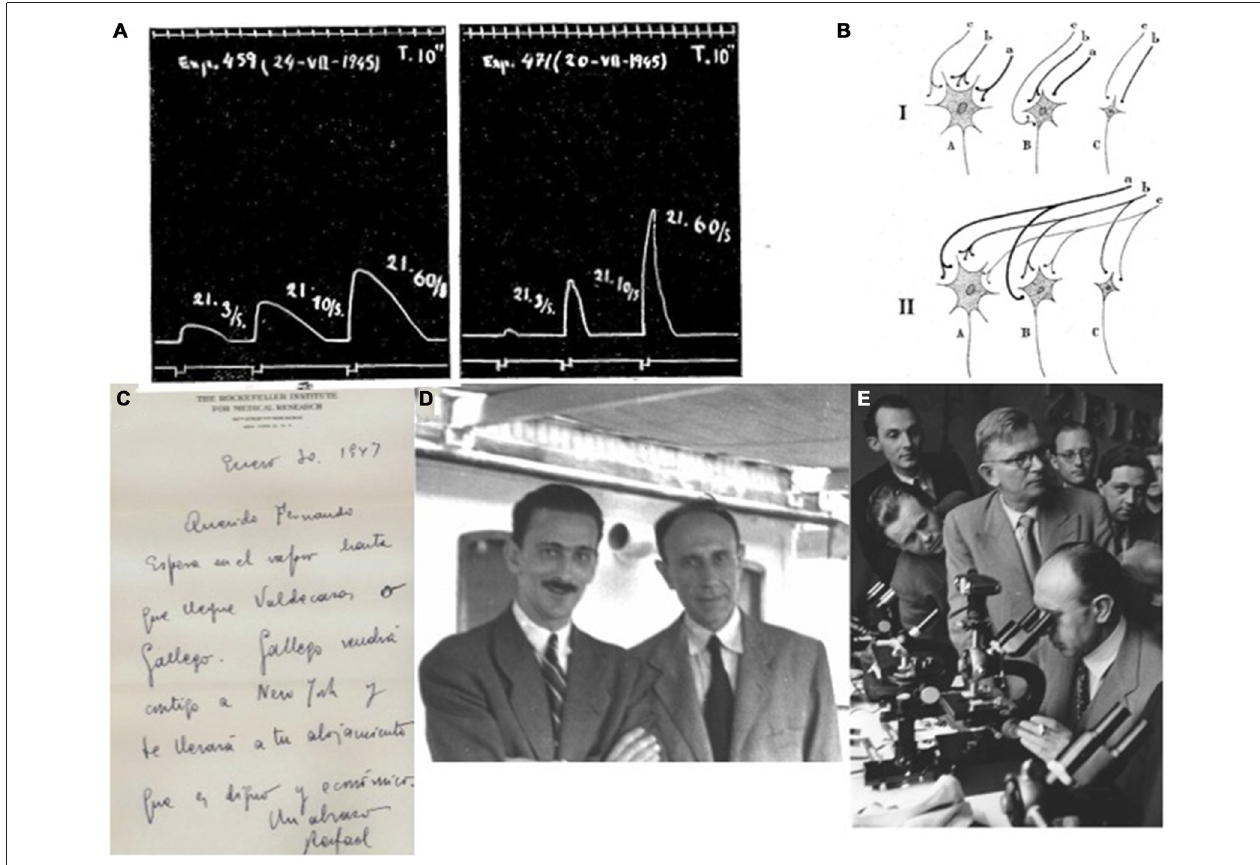
FIGURE 5 | Post-war de Castro on the autonomic nervous system and their synaptic structure. (A) Electromiographic recordings of the nictitant membrane of the adult cat where the sympathetic superior cervical ganglion has been innervated by rami from the VI-c and VII-c nerves (de Castro and Herreros, 1945). This 10 s-recording shows that the intensity of the contraction correlates with the frequency of the tetanic stimulation. (B) Schematic representation of the preganglionic convergence of fibers ( a , b , c ) onto ganglionic cell types ( A , B , C ). The thickness of the fibers is representative of their thickness in vivo . In this it is assumed that ganglion cells can trigger when activated by two boutons simultaneously, or in the slow fibers ( c ) when a sinchronic impulse via a-b facilitates it (de Castro and Herreros, 1945). (C) Original letter from Rafael Lorente de Nó to Fernando de Castro (dated at the Rockefeller Institute, New York on January 30th, 1947): “Dear Fernando, Wait at the shipboat till the arrival of Valdecasas or Gallego. Gallego will come with you to New York and will bring you to your accomodation, that is worthy and economic. Hugs, Rafael” (translated by the autor of this work from Spanish). (D) Antonio Gallego (1915–1992) and Fernando de Castro on board of the Motomar steamship, in their way back to from New York to Spain (1947) after their respective first scientific experience at the USA. (E) Fernando de Castro (at the microscope), invited speaker to expose the cytoarchitecture of the autonomic nervous system. Became one of the main characters in the final offical defeat of reticularists at the 34 Tagung Deutschen Gesselchaft fü Pathologie (Wiesbaden, Germany; 1950). His friend, the German histologist established in Chile, Emil Herzog (on foot, with glasses, just behind Fernando de Castro) acts as de Castro’s master of ceremony at that time, (A–E) are part of Archive Fernando de